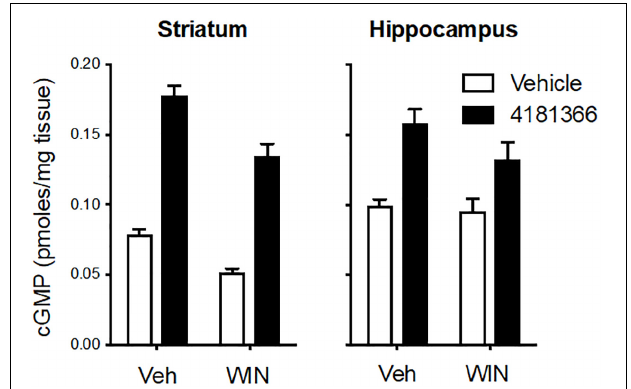
FIGURE 3 | Inhibition of CB1 receptors only slightly attenuated the increase in cGMP induced by PDE9A inhibition. The CB1 receptor antagonist WIN 55,212 (WIN, 10 mg/kg, i.p.) was administered 20 min before administration of PF-4181366 (10 mg/kg) and animals were sacrificed 30 min later. WIN alone caused a decrease in cGMP in striatum but had no effect in hippocampus. PF-4181366 elevated cGMP levels in both brain regions in the absence or presence of WIN. Results were analyzed by two-way ANOVA (PF-4181366 × WIN) in both brain regions followed by post hoc tests of